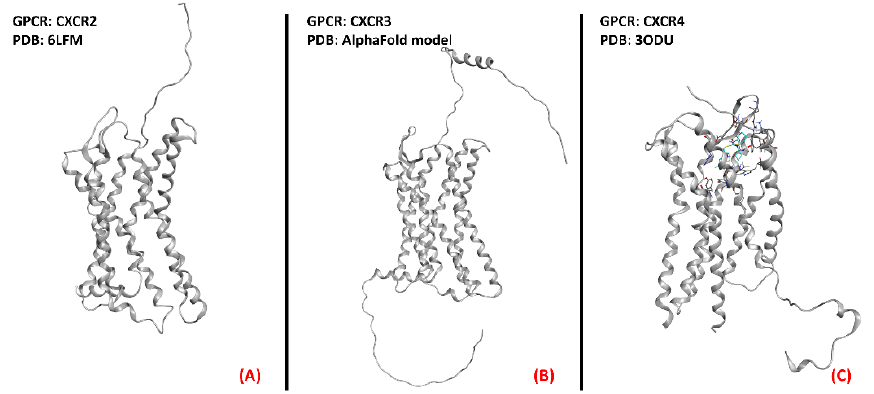
Figure 7. Representation of the three-dimensional structures of the chemokine receptors that could be considered for ALS treatment. CXCR2 ( A ) receptor (sourced from the Protein Data Bank, PDB code: 6LFM [104], method: cryo-EM, resolution: 2.50 Å), CXCR3 ( B ) (with no experimentally resolved structure available, the model from the AlphaFold [105] database is presented), and CXCR4 ( C ) receptor (sourced from the Protein Data Bank, PDB code: 3ODU [106], method: X-ray diffraction, resolution: 2.50 Å ).The images were created and rendered with MOE.